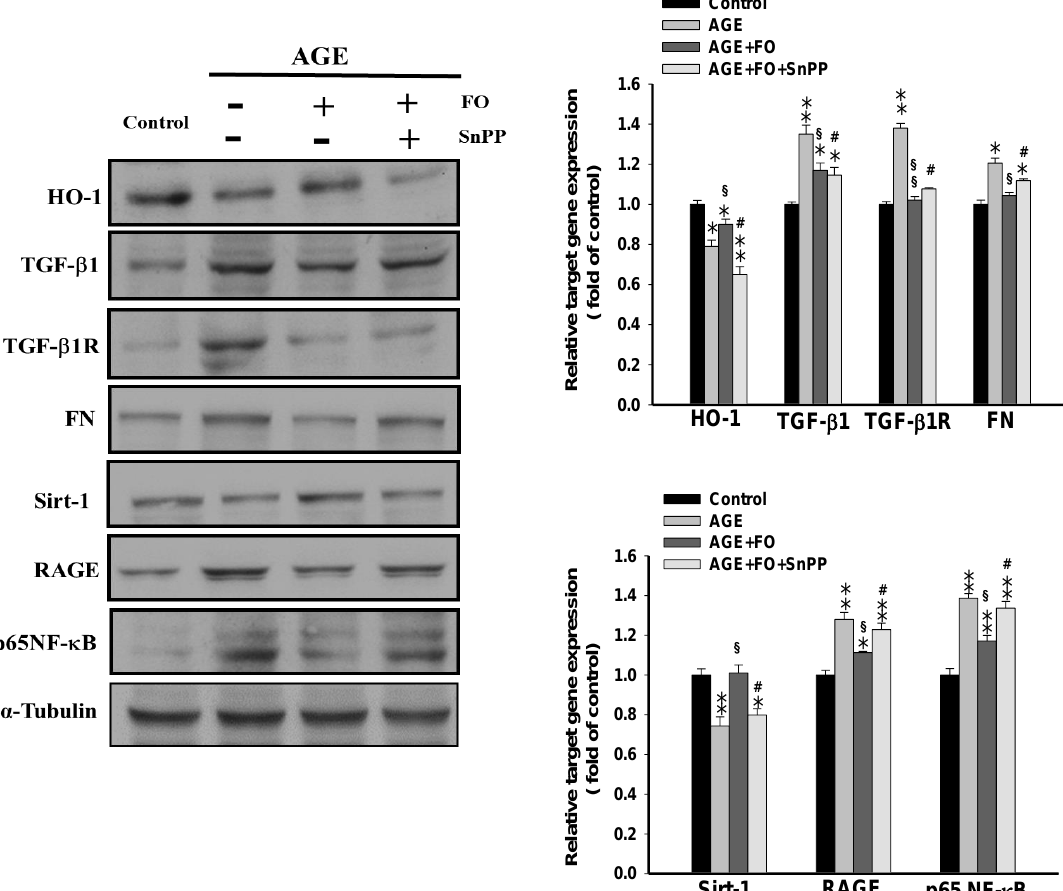
Figure 3. The e ff ects of tin protoporphyrin IX (SnPP) on fucoidan-regulated target gene expression. The NRK-52E cells were incubated with AGE (100 µ g / mL) for 24 h, followed by treatment with fucoidan (100 µ g / mL) for 24 h in the presence or absence of SnPP (20 µ M). The alterations of target gene expression were determined in various groups. Results were expressed as the mean ± S.E.M ( n = 5). * p < 0.05, ** p < 0.01 vs. control group; § p < 0.05, §§ p < 0.01 vs. AGE-treated alone cells; # p < 0.05 vs. AGE and fucoidan-treated